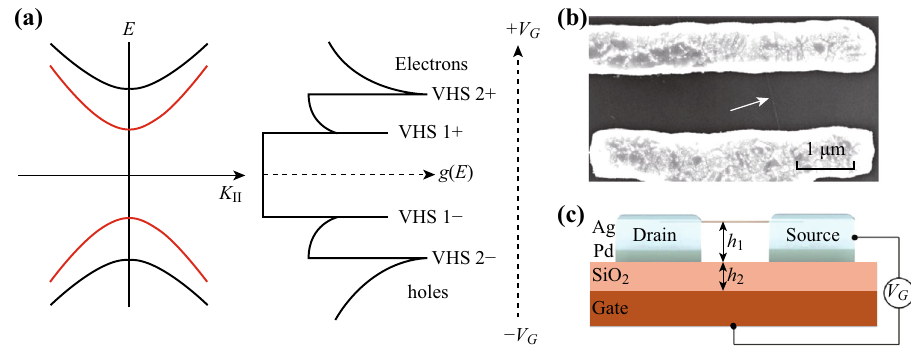
Fig. 1 a Schematic of the electronic band structure (left) and DOS (right) of a semiconducting SWNT. Four sharp VHSs (VHS 1 ? , VHS 1 - , VHS 2 ? , VHS 2 - ) appear at the onset of each subband. b Typical SEM image of a back-gate SWNT transistor. The SWNT is suspended, and the channel length is about 1 l m. c Schematic of the suspended SWNT transistor. The height of the suspended SWNT and the thickness of the insulating layer (SiO 2 ) are 500 and 800 nm, respectively